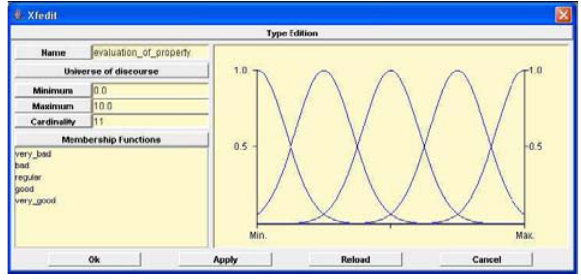
Fig. 9: Fuzzy sets for the